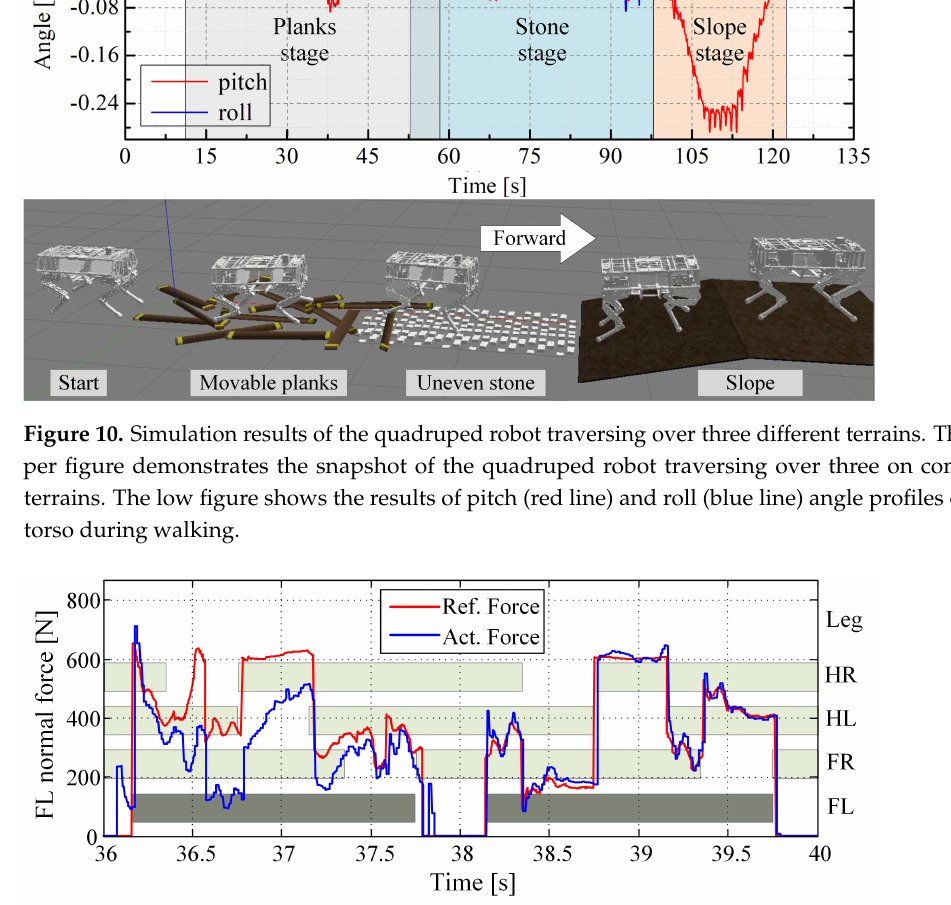
Figure 11. The results of the fore-left (FL) normal force of the quadruped robot walking on movable planks with the proposed torque control scheme. HR, HL, and FR represent the hind-right, hind-left, and fore-right leg, respectively. Bar patterns indicate the stance duration. Red line indicates the reference normal forces. Blue line is the actual normal